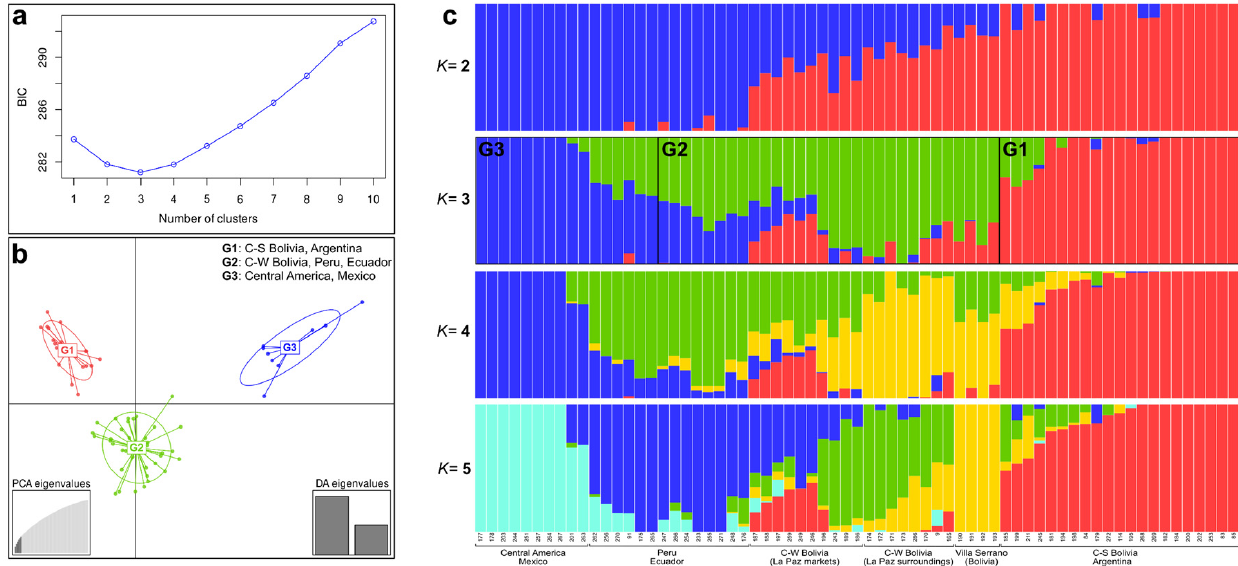
Figure 3. Genetic clustering and differentiation of 67 C. pubescens samples using 1462 unlinked biallelic SNPs. ( a ) Bayesian information criterion (BIC) values for different number of clusters ( K ). ( b ) Discriminant analysis of principal components (DAPC) at K = 3. Six PCs and two discriminant eigenvalues were retained during analyses to describe the relationships among the clusters. Each circle represents a genetic cluster, and each dot represents a sample. The different colours represent the three clusters. ( c ) Cluster assignments for K = 2–5 estimated in Admixture. Each bar represents a sample and the colours represent partitioning of the sample genotype in each group. The accessions are sorted according to phylogenetic network grouping (Figure 2a). G, genetic